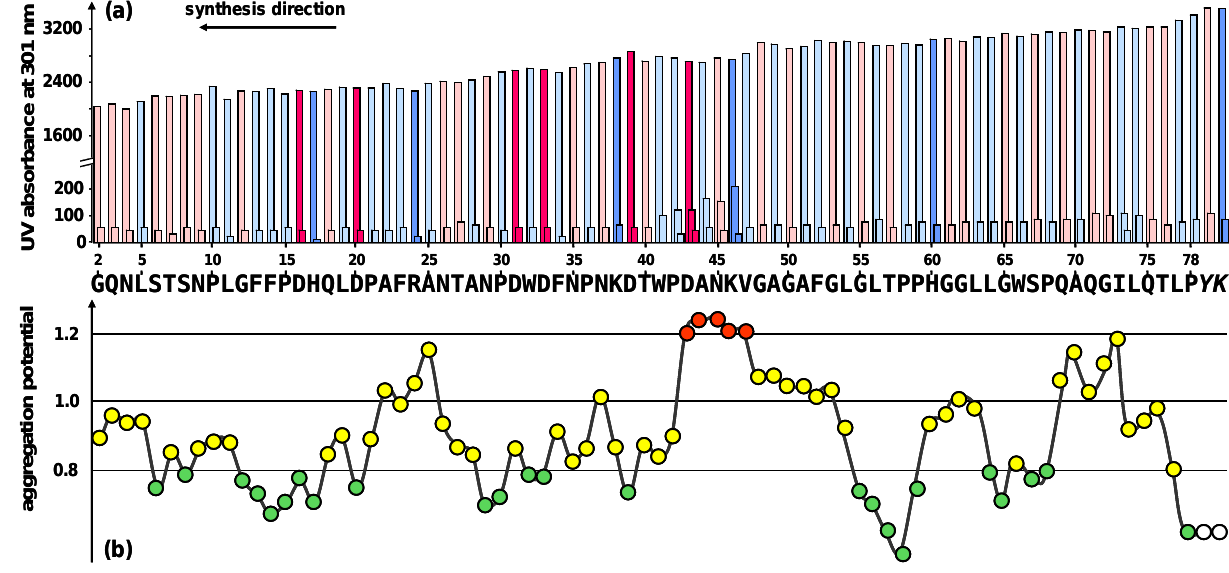
Figure 2. (a) UV measurement (Fmoc cleavage pattern) of the peptide synthesizer during the standard stepwise synthesis of HBVpreS/2-78. The value for the second deprotection step is shown in a fourfold enhancement. Colours used for the different amino acids: rose (polar), light blue (unpolar), pink (acidic) and blue (basic). A slight gradual decrease of the Fmoc cleavage value was observed. In the region from aa 42 to aa 46 an additional deprotection step was necessary. (b) Prediction of synthetically difficult sequences according to the aggregation potential of the growing peptide chain [17]. A graphical representation of the aggregation potential for amino acids starting from the third position of the peptide chain is presented. The sequence shows potential difficult couplings after two or three consecutive potentials have exceeded the value 1.1: the peptide chain tends to aggregate resulting in a slower aminoacylation. For the sequence motif presented, the program shows difficulties within the positions 43 to 47 of the peptide sequence (shown in